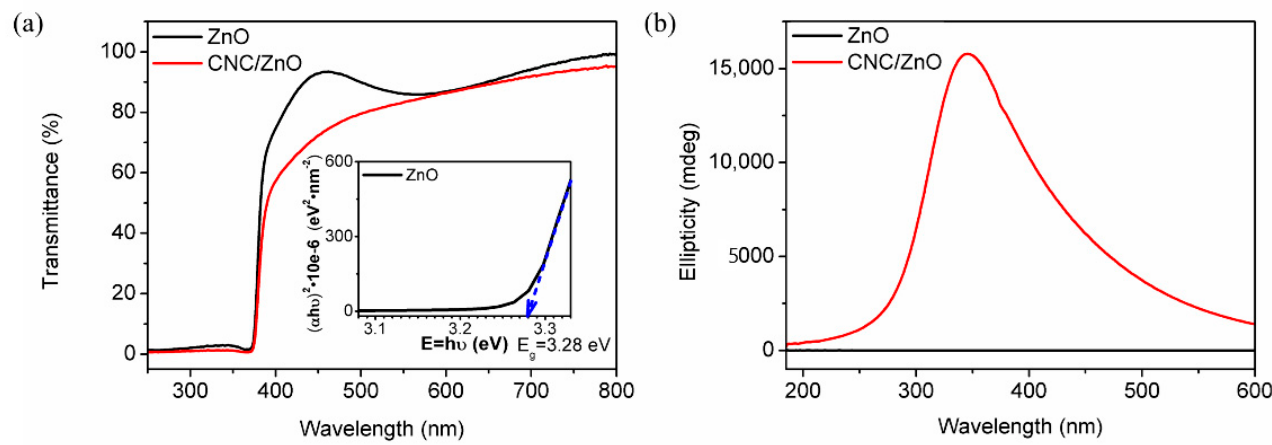
Figure 4. ( a ) Transmittance spectra of ZnO layer and CNC/ZnO photodetector. Insert: Plot of ( α h ν ) 2 versus photon energy for ZnO layer. ( b ) CD spectra of ZnO layer and CNC/ZnO photodetector.